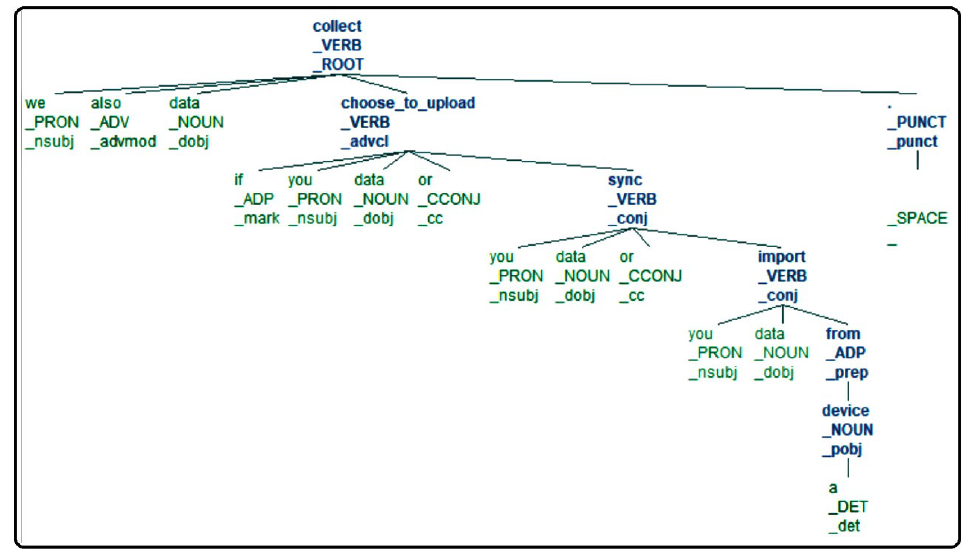
Figure 6. Rephrase-policy (M1) upon dependency parser